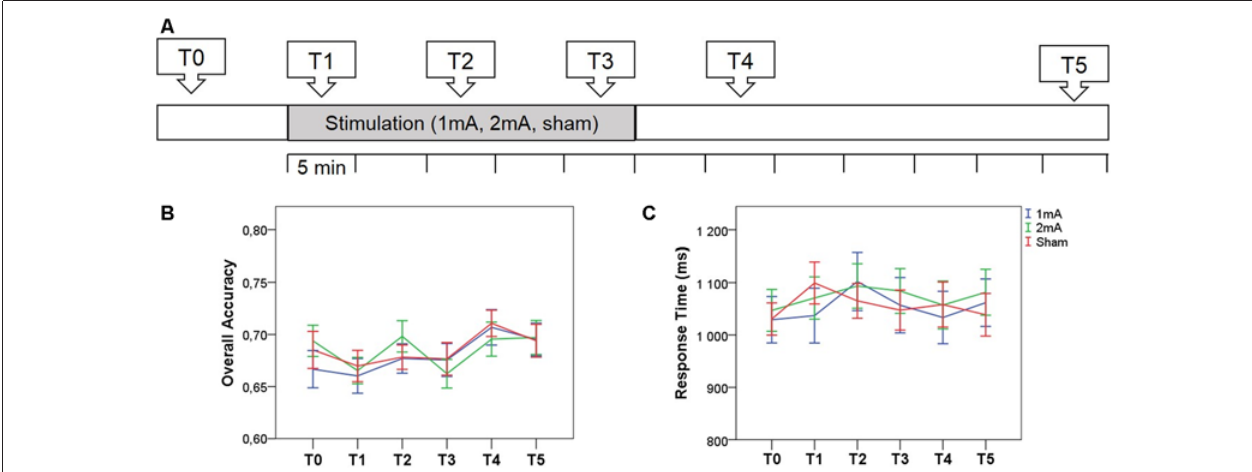
FIGURE 2 | (A) Experimental design. Three-back performance was assessed before (T0), during (T1 − T3) and after (T4 − T5) anodal tDCS over the left dlPFC. Stimulation conditions were randomized for each participant and the order was counterbalanced. (B,C) The effect of stimulation condition on overall accuracy and response time at the six assessment time points. Error bars represent standard error of the